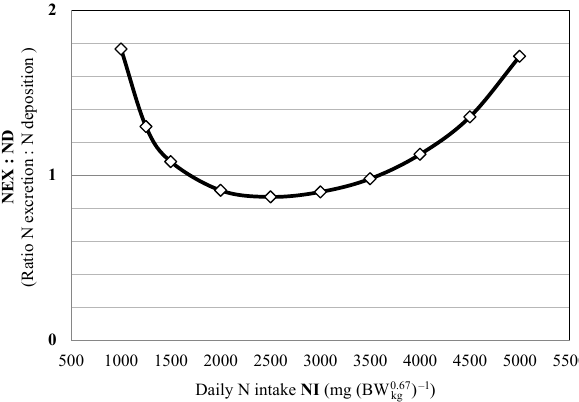
Figure 2. Course of N excretion per unit N deposition (NEX:ND) as derived from N balance data and exponential function of NEX dependent on N intake in growing pigs of 50kgBW (Wecke and Liebert,